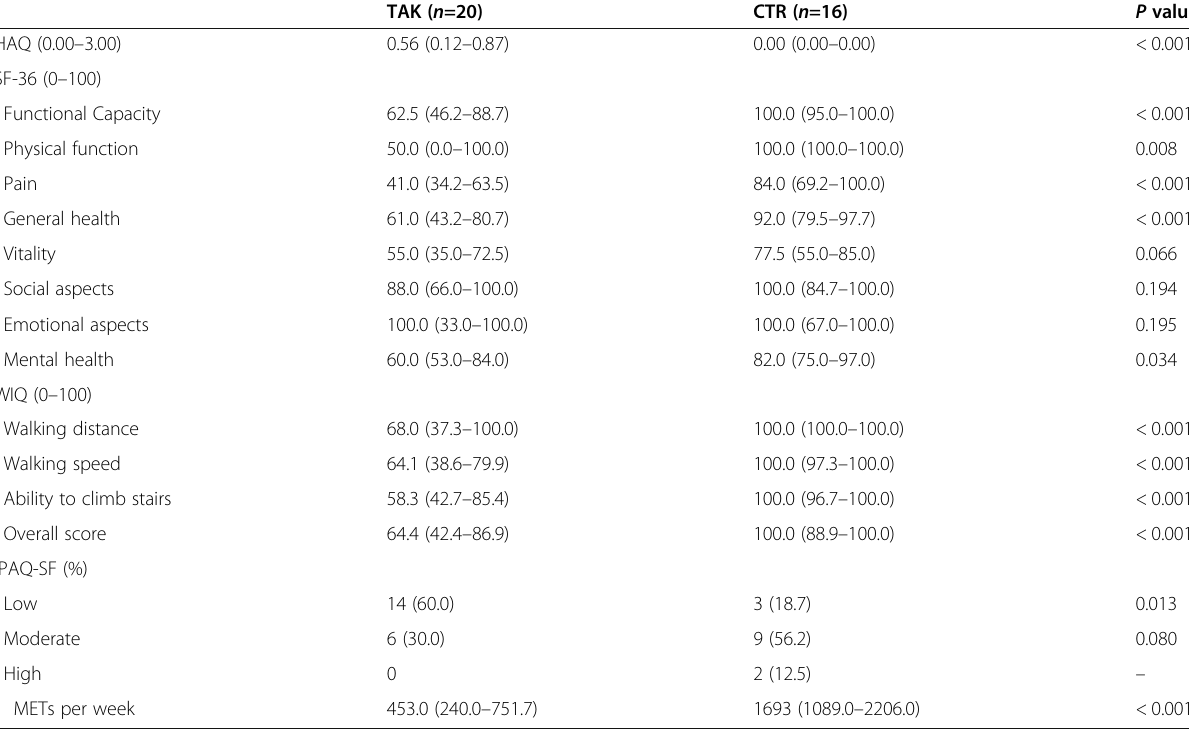
Table 4 Ability to perform activities of daily living, quality of life and level of physical activity of patients with Takayasu arteritis and the control group